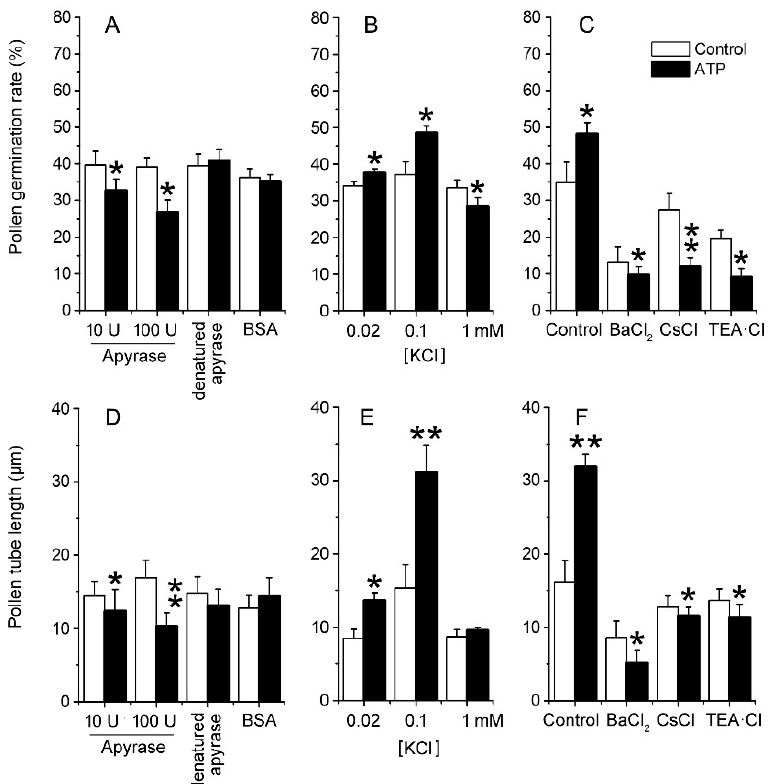
Figure 2. eATP regulates the PG and PTG of Arabidopsis thaliana by facilitating K + uptake. Apyrase-inhibited PG ( A ) and PTG ( D ), ATP-regulated PG ( B ), and PTG ( E ) in medium containing serial concentrations of KCl. K + channel blockers (1 mM) inhibited ATP-promoted PG ( C ) and PTG ( F ). In ( A – F ), the K + concentration in the medium is 0.1 mM. In each experiment, at least 300 pollen grains were counted to obtain PG, and at least 150 pollen tubes were measured to obtain the pollen tube length. Data from 3 replicates were combined to obtain the mean ± SD. Student’s t test p values: * p < 0.05, ** p < 0.01.